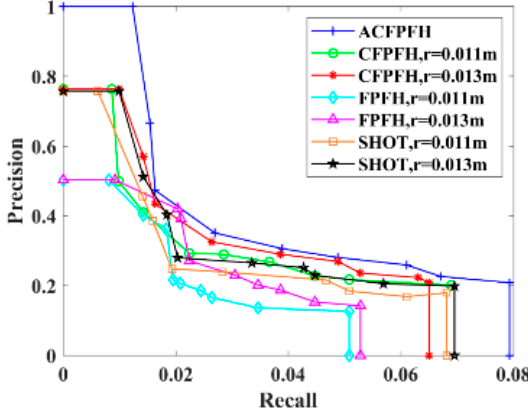
Figure 17. PRC of different feature descriptors.